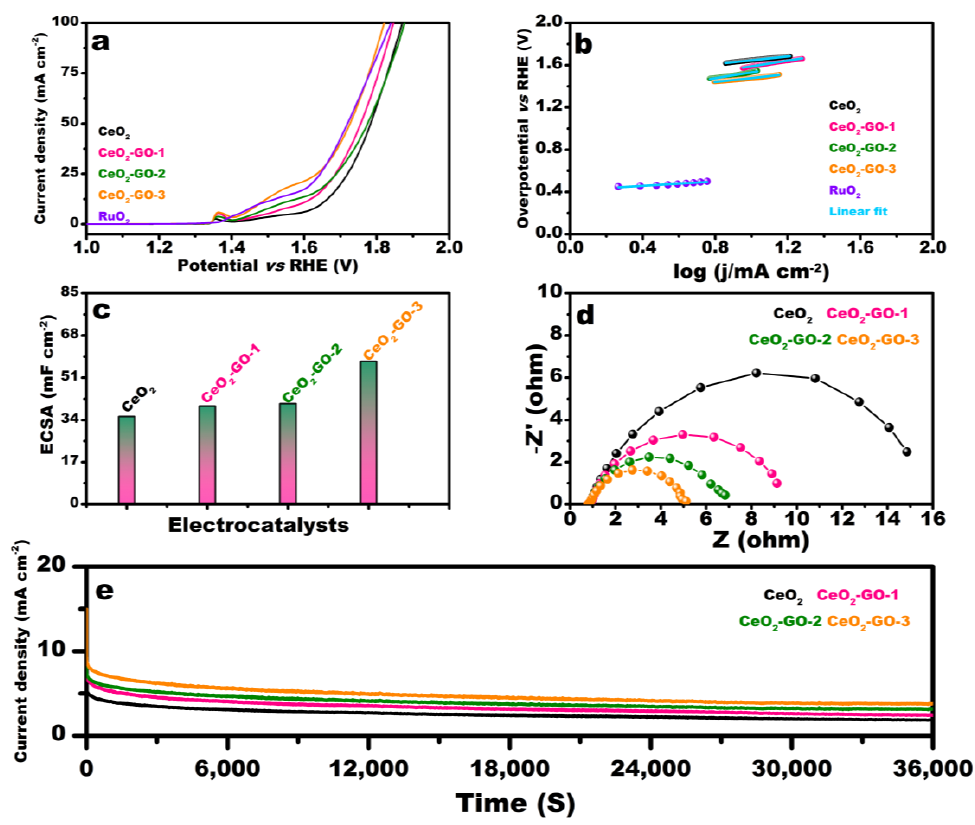
Figure 6. Electrochemical investigation of the electrocatalysts: ( a ) LSV curves, ( b ) Tafel slope, ( c ) bar diagram of the ECSA values, ( d ) Nyquist plots, and ( e ) chronoamperometry curves. The Tafel slope is a crucial parameter for identifying the relationship between the overpotential and steady-state current density of electrocatalysts [66]. Figure 6b shows Tafel slopes of 261, 293, 185, 176, and 101 mV dec −1 for CeO 2 , CeO 2 –GO-1, CeO 2 –GO-2, CeO 2 –GO-3, and RuO 2 electrocatalysts, respectively. The CeO 2 –GO-3 electrocatalyst re- vealed a smaller Tafel slope than the other electrocatalysts, showing its higher OER activ- ity owing to the higher percentage of GO. However, compared with RuO 2 , the CeO 2 –GO- 3 Tafel slope value was higher. The electrochemical active surface area (ECSA) is directly related to the electrochemical performance of the electrocatalysts [69,70]. A higher ECSA indicates better electrochemical performance. In the present work, the ECSA was meas- ured using the CV curves in the non-faradaic region; the corresponding CVs are shown in Figure S7. The CeO 2 –GO-3 electrocatalyst showed a higher ECSA (57.5 mF cm −2 ) than the other electrocatalysts (35.4, 39.4, and 40.5 mF cm −2 for CeO 2 , CeO 2 –GO-1, and CeO 2 –GO-2, respectively), as shown in Figure 6c.